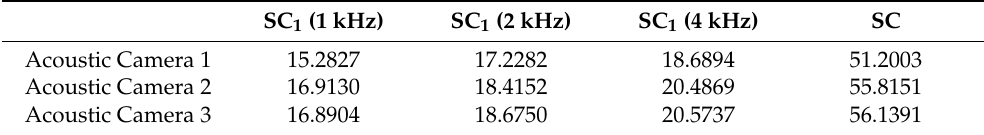
Table 8. The overall score of all acoustic camera